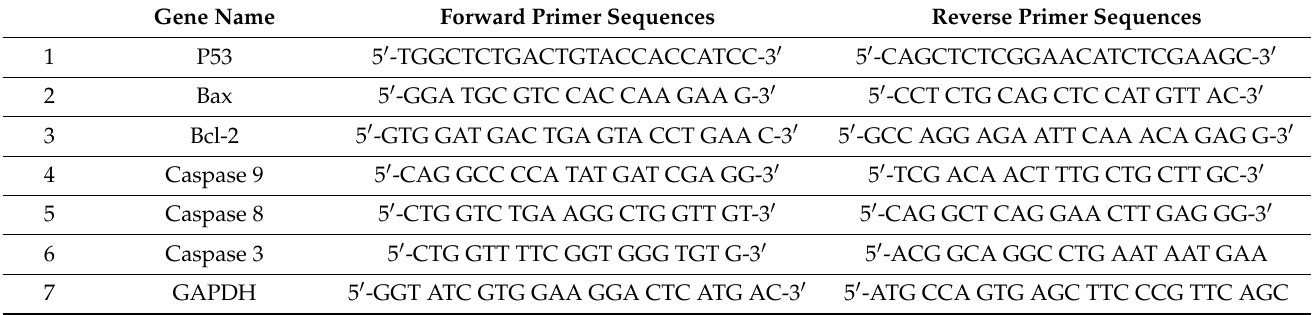
Table 1. Primer sequences for quantitative real-time polymerase chain reaction